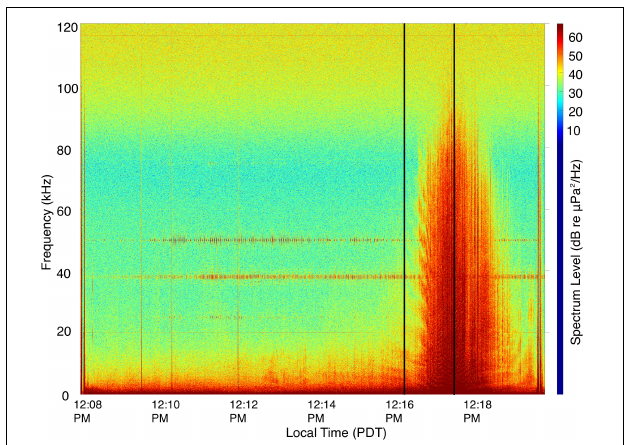
FIGURE 3 | Spectrogram showing the acoustic signal of the Mokihana during the CPA as recorded on the DTAG-3 hydrophone. The first black vertical line indicates the onset of a behavioral response by the whale. The second black vertical line indicates the CPA with the Mokihana. Spectrogram parameters: NFFT = 240000, 90% overlap, Hanning